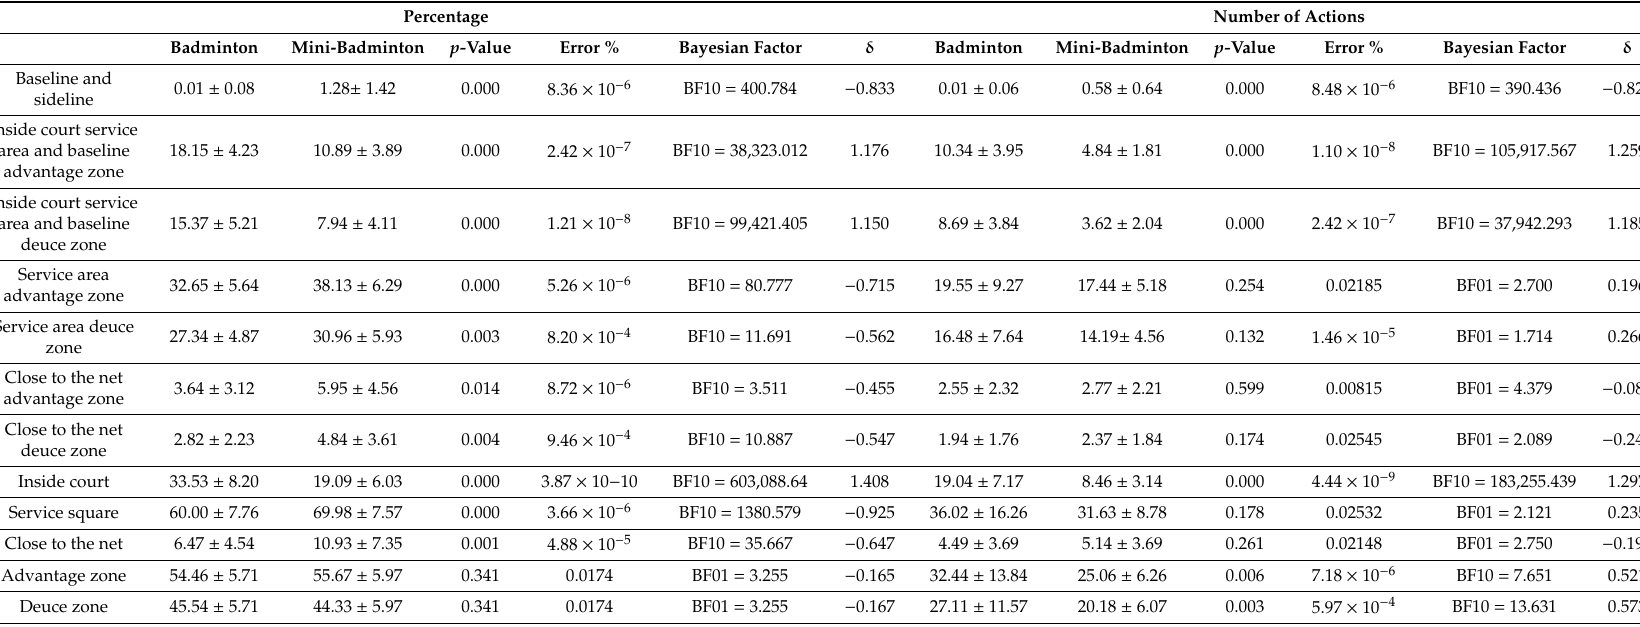
Table 5. Bayesian analysis of usage percentage and stock count technical and tactical in consideration of players’ hitting